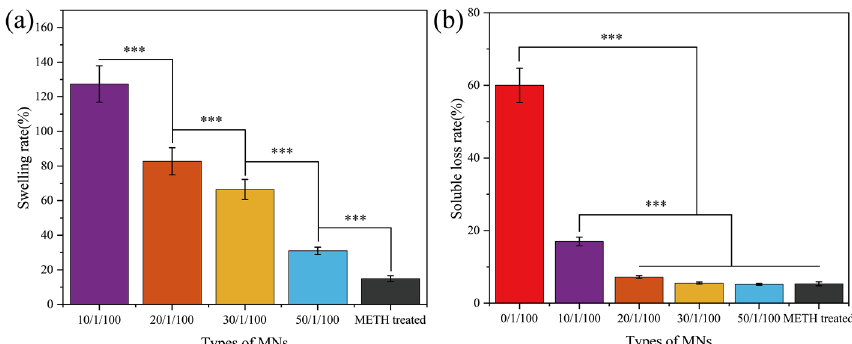
Figure 7. Swelling and dissolution loss of MT/SF@MNs’ ( a ) swelling rate and ( b ) soluble loss rate measured by ultraviolet spectrophotometer. (*** p ≤ 0.001).